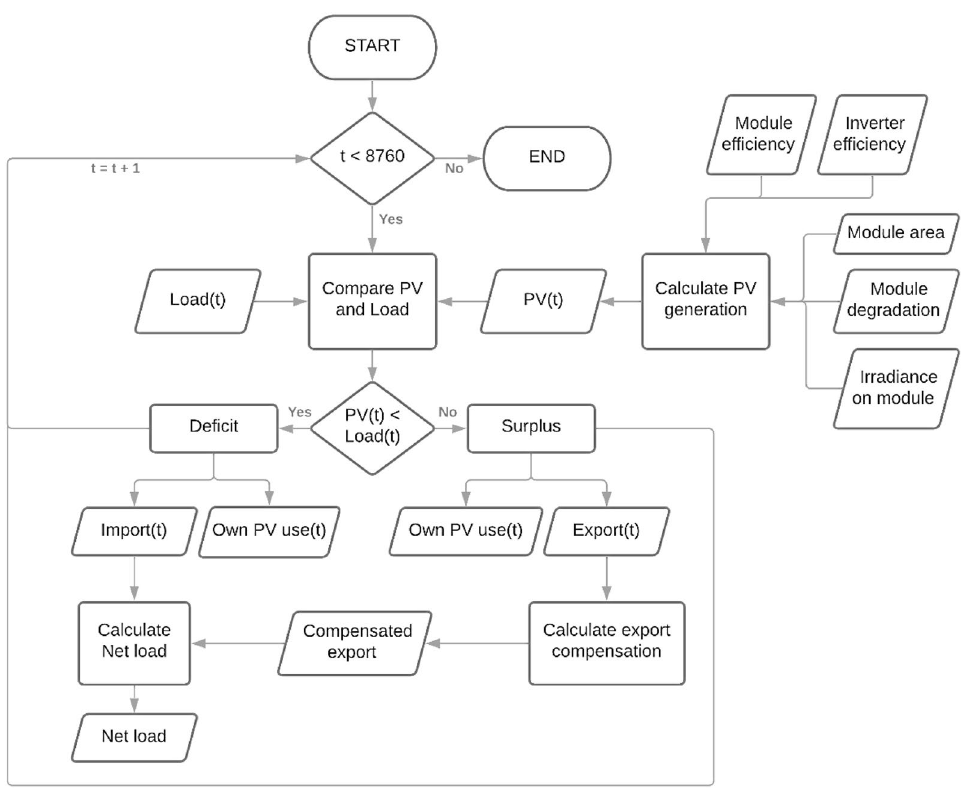
Figure 4. RSPP operational